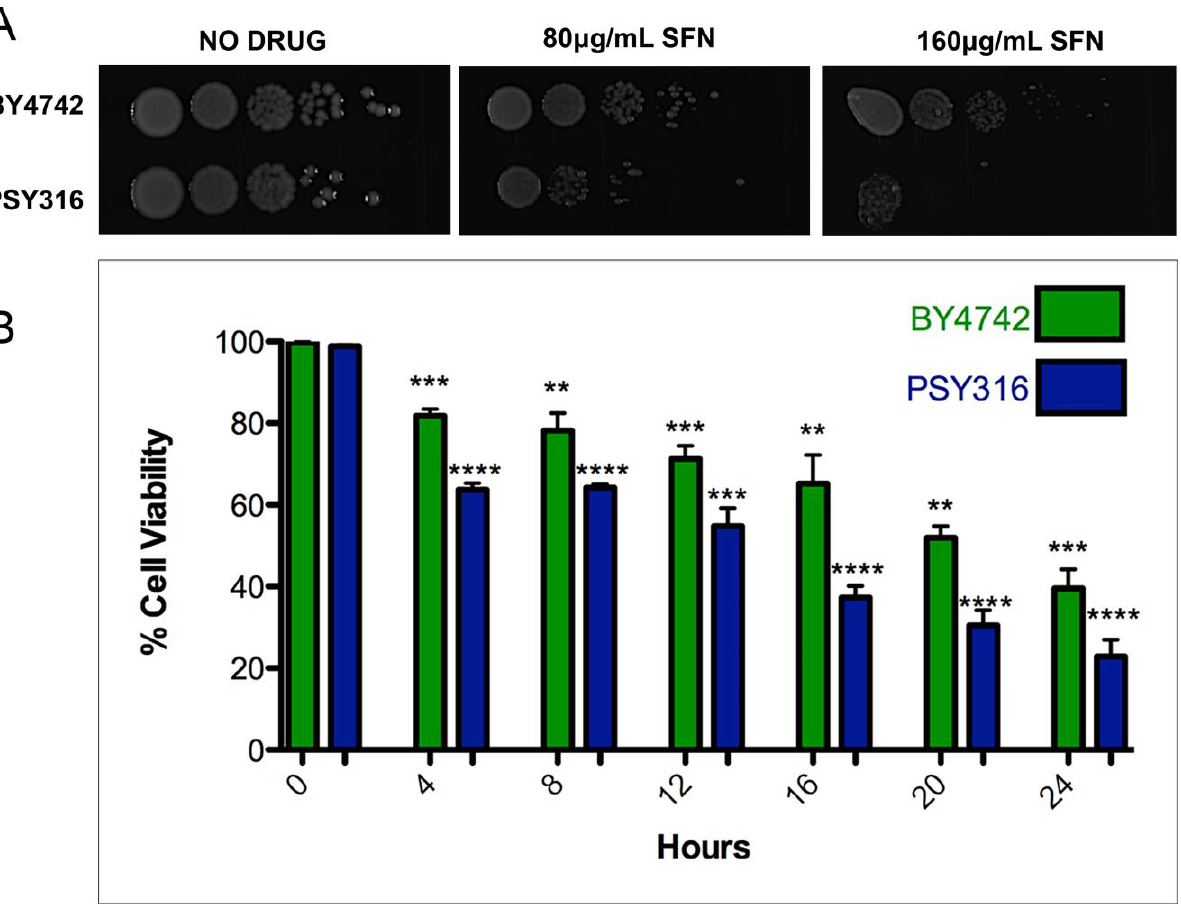
FIGURE 1: SFN inhibits the growth of yeast cells with mutations. (A) Ten-fold serial dilutions of wild type yeast cells from the BY4742 and PSY316 strain backgrounds were plated on synthetic defined (SD) media with increasing concentrations of SFN and allowed to grow at 30°C for two days. (B) Wild type cells from both the BY4742 and PSY316 strain backgrounds were grown in synthetic defined (SD) liquid cultures containing 100 μ g/mL of SFN. The viability of the cells at the indicated time points was determined using propidium iodide (PI) as a vital stain and compared to the zero time point as control. Dead yeast cells stain with PI. Error bars indicate standard deviations for trials with at least three independent cultures. The difference in viabilities was deemed statistic ally significant by the Student’s t -test comparing cells grown in SFN with control cells grown without drug (* p<0.05; ** p<0.01; *** p<0.001; ****